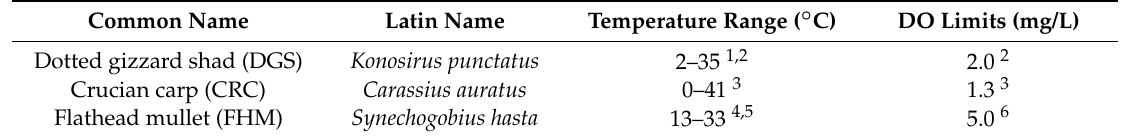
Table 3. Habitat temperature and DO criteria for three major fish species in GAW.